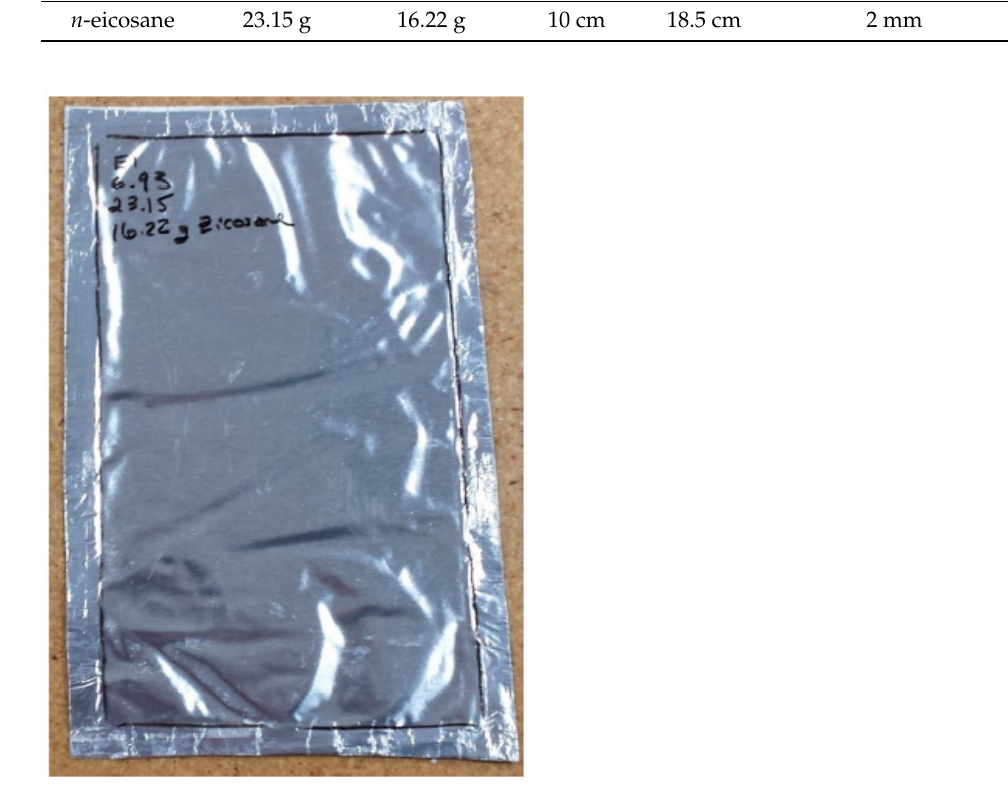
Figure 3. Photograph of the LHTES module.